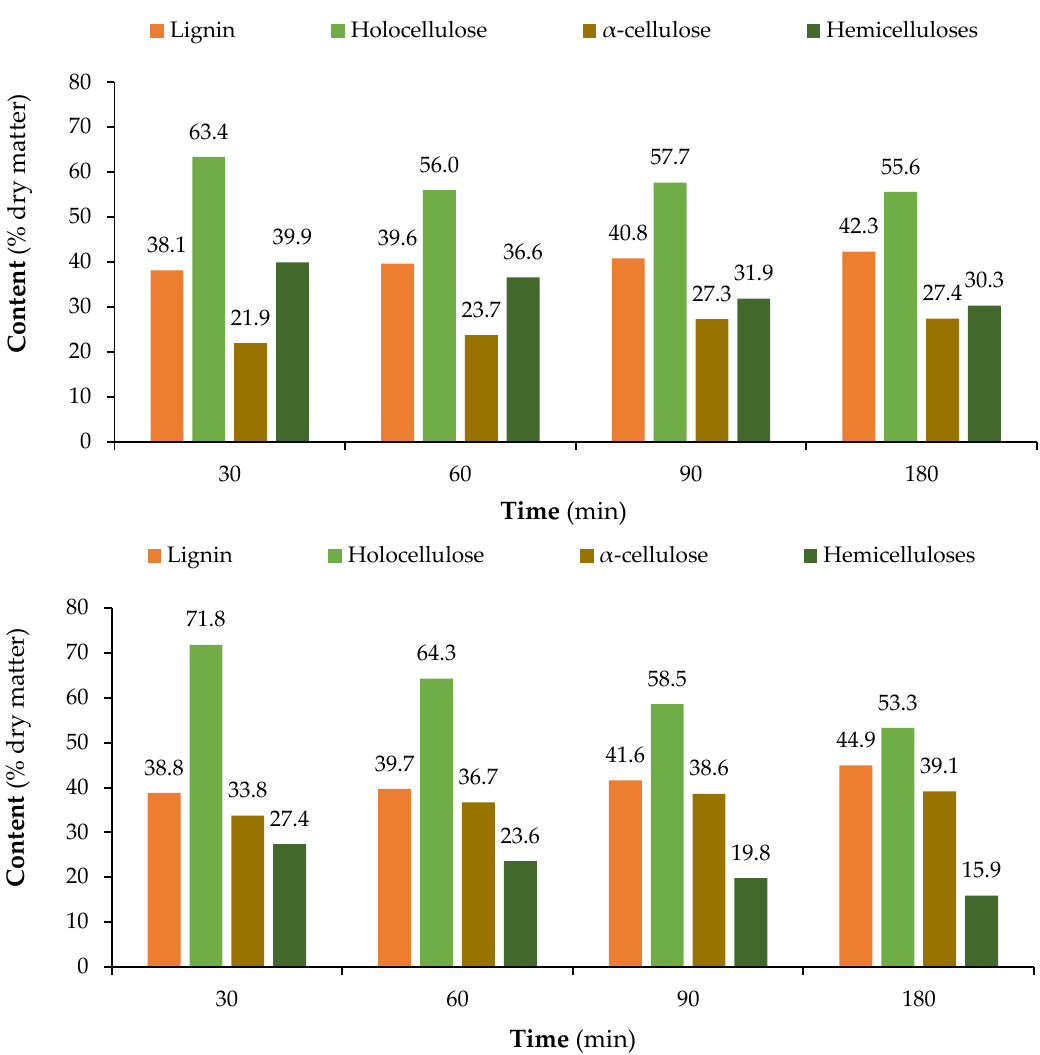
7 of 13 Figure 2. Pre-hydrolysis of SCS. Liquefaction yield with time. Figure 3 presents the chemical composition variation over the several pre-hydrolysis steps at both temperatures of 160 °C and 170 °C. For α-cellulose, the values obtained for the two temperatures are very different. There is a significant increase in α-cellulose from 23.1% in the original sample to 39.1% at 170 °C, but only a moderate increase at 160 °C to 27.4%. The increase in α-cellulose shows